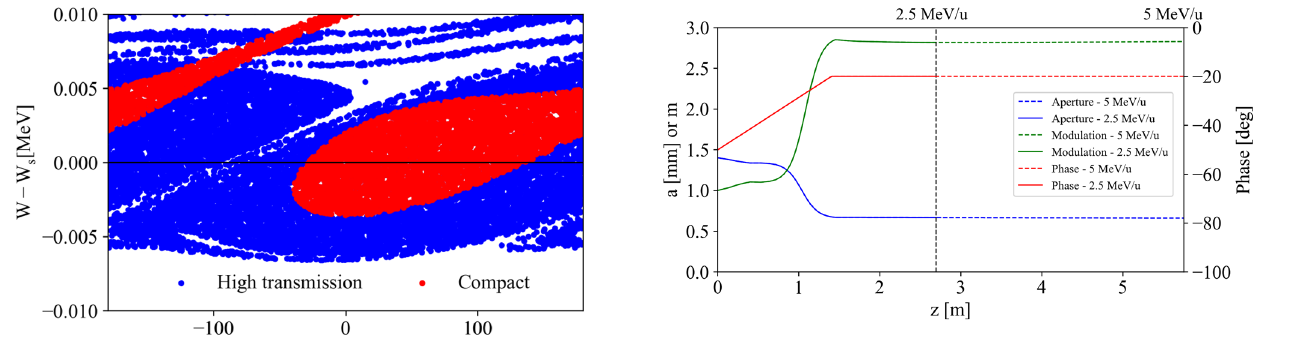
FIG. 6. Modulation, synchronous phase, and minimum aperture of the compact RFQ are plotted for the two final energies of 2.5 MeV/u (continuous line) and 5 MeV/u (dashed